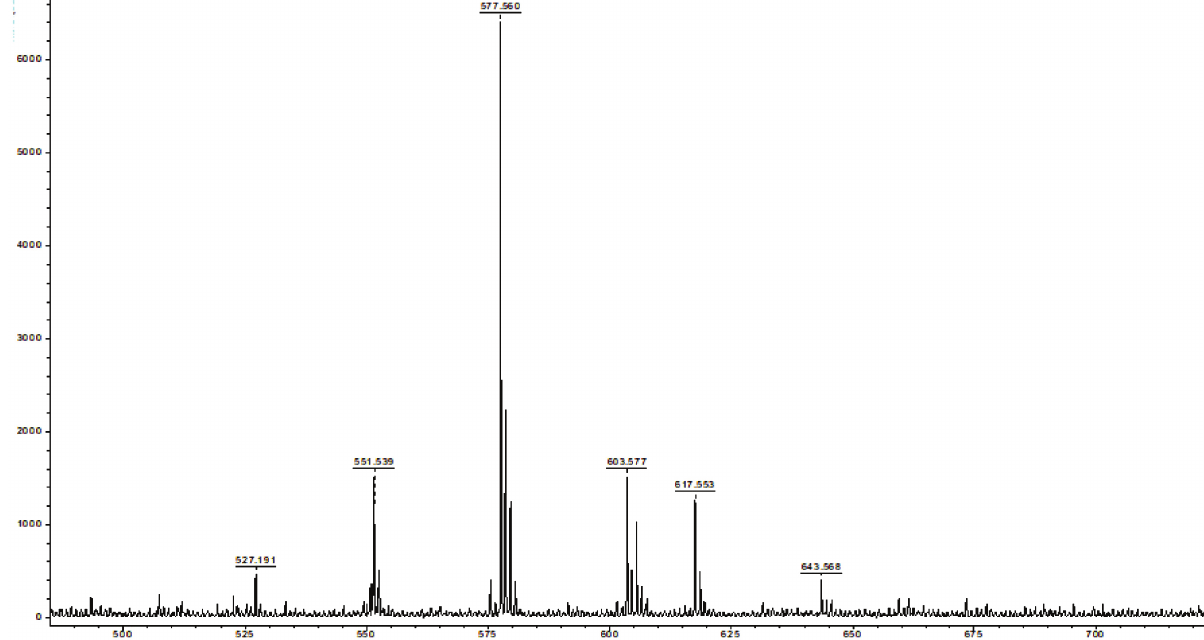
Fig. 4 – MALDI-TOF MS spectra of EPS separated from cell-broth by ethanol